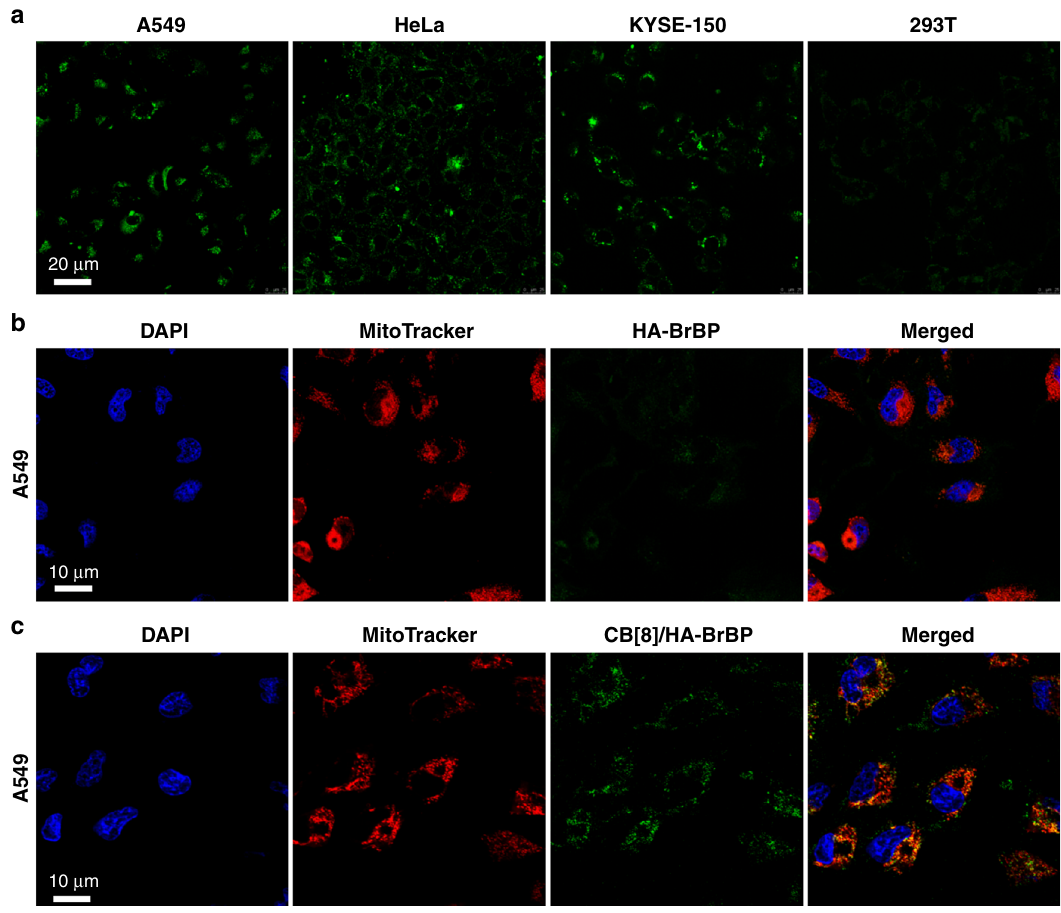
Fig. 6 Confocal microscopy images. a A549, HeLa, KYSE – 150 and 293T cells incubated with CB[8]/HA – BrBP ([BrBP] = 25 µ M, [CB[8]] = 12.5 µ M). b A549 cells incubated with HA – BrBP ([BrBP] = 25 µ M). c A549 cells incubated with CB[8]/HA – BrBP ([BrBP] = 25 µ M, [CB[8]] = 12.5 µ M).